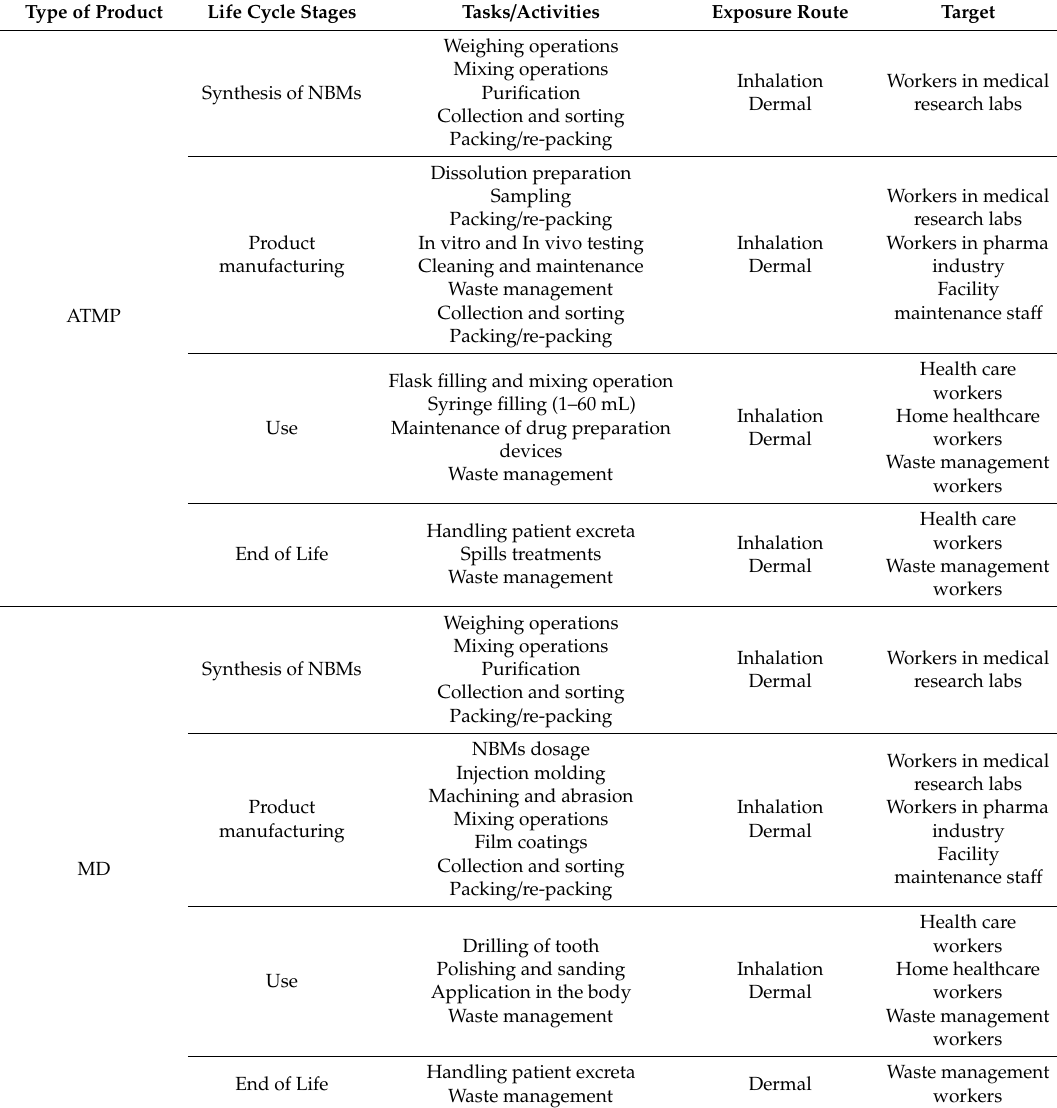
Table 1. Examples of occupational exposure routes and targets for tasks / activities identified within life cycle of NBMs used in MD and